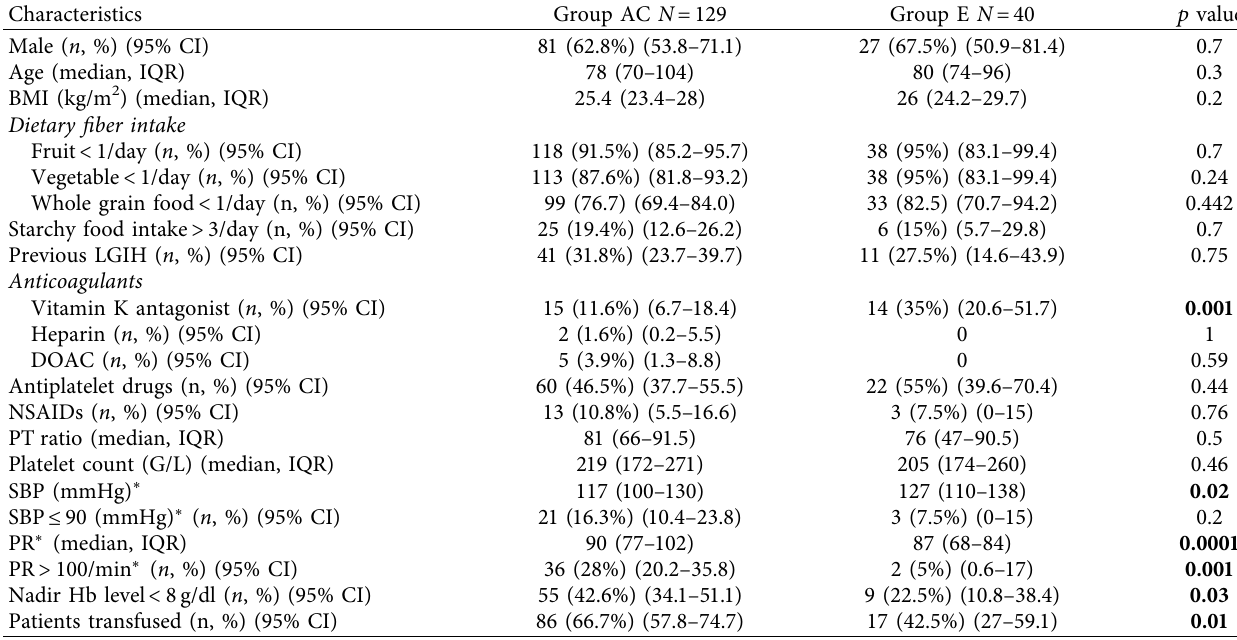
Table 1: Characteristics of patients included in the study.